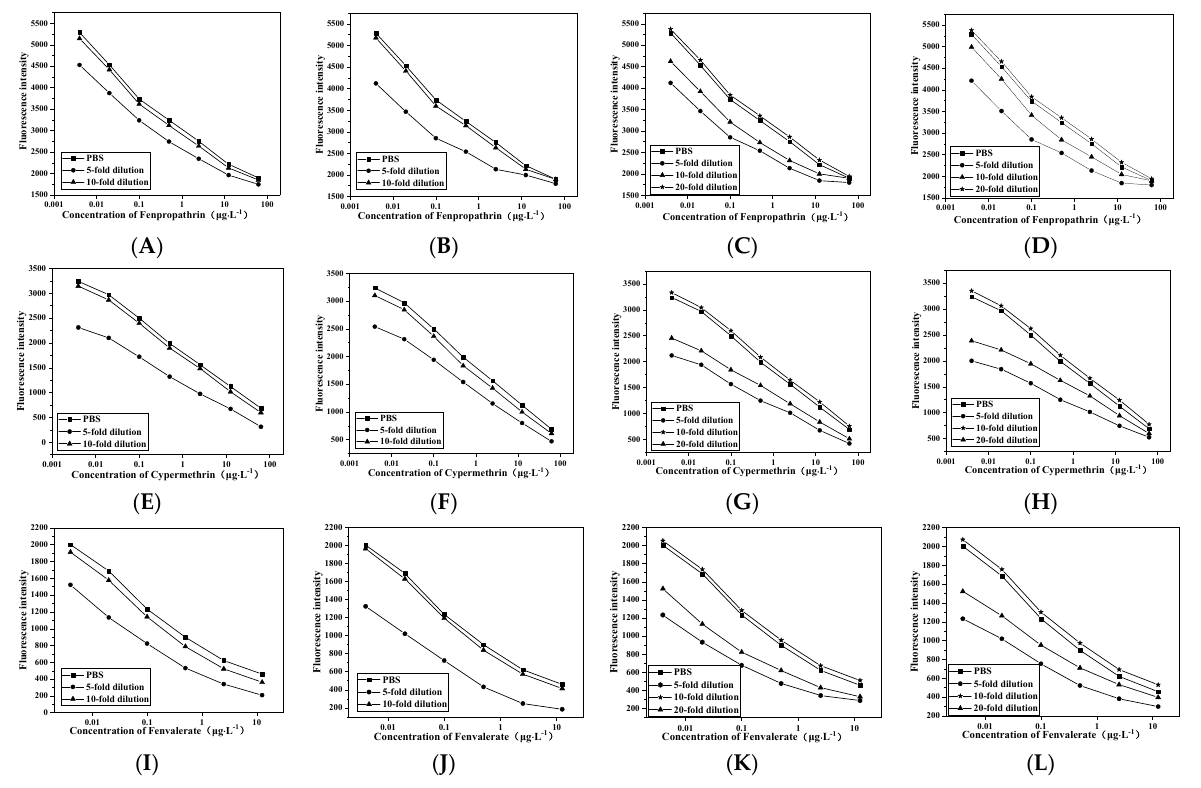
Figure 5. ( A , E , I ) Elimination results of matrix effect of cucumber; ( B , F , J ) cabbage; ( C , G , K ) apple; and ( D , H , L ) pear.